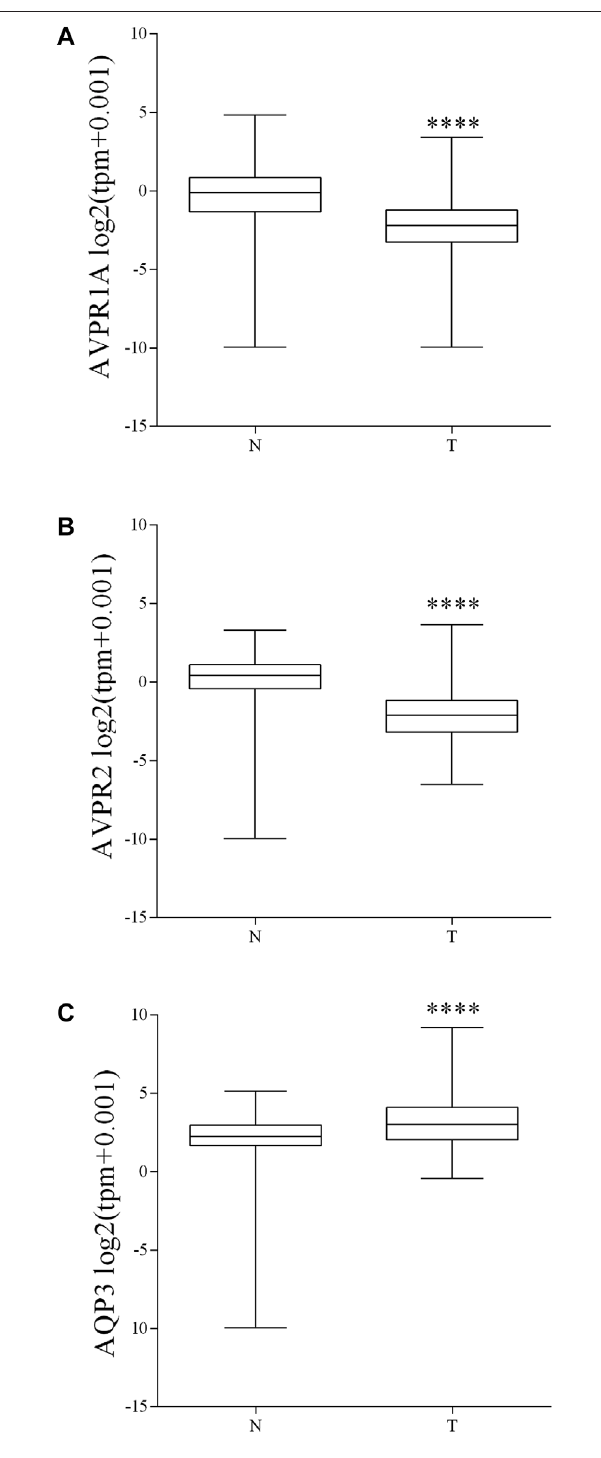
FIGURE 14 | Expression of Vasopressin receptors and AQP3 genes in human colon adenocarcinoma. Publicly available pre-analyzed gene expression (tpm) data from 288 primary colon tumors and 308 normal colon controls were downloaded and plotted as distribution in log2 (tpm+0.001) values. (A – B) Bioinformatic analysis of RNA-Seq showed that in colon cancer, gene expression of vasopressin receptors is signi fi cantly